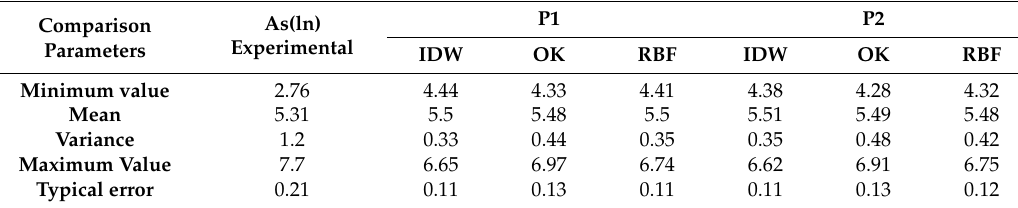
Table 3. Statistical data estimated by interpolation methods for P1 and P2.